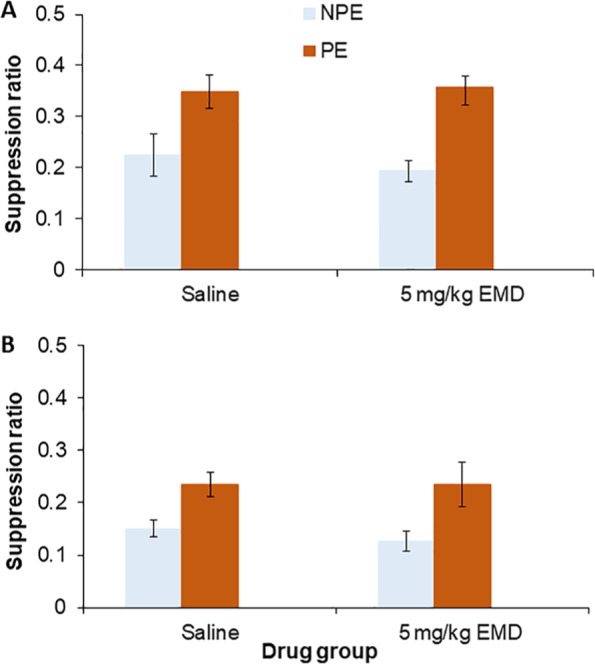
(A) Mean suppression ratio (±SEM) to the light for control (light blue) and pre-exposed (PE; dark orange) groups following treatment with saline or 5 mg/kg EMD386088 in Experiment 1 (n = 47). (B) Mean suppression ratio (±SEM) to the noise for control (light blue) and pre-exposed (dark orange) groups following treatment with saline or 5 mg/kg EMD386088 in Experiment 2 (n = 48).Note: SEM = standard error of the mean.